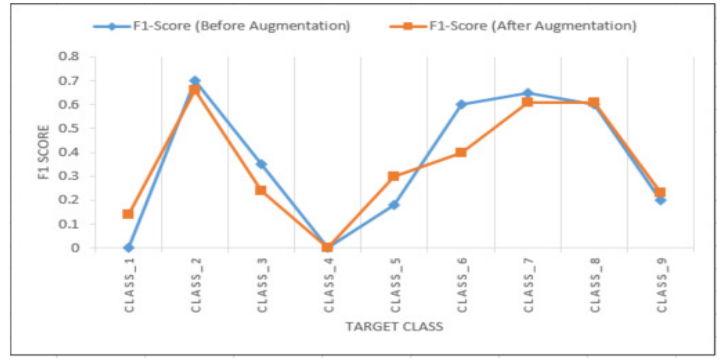
Figure 6. Confusion matrix for random forest trained on injury narratives.